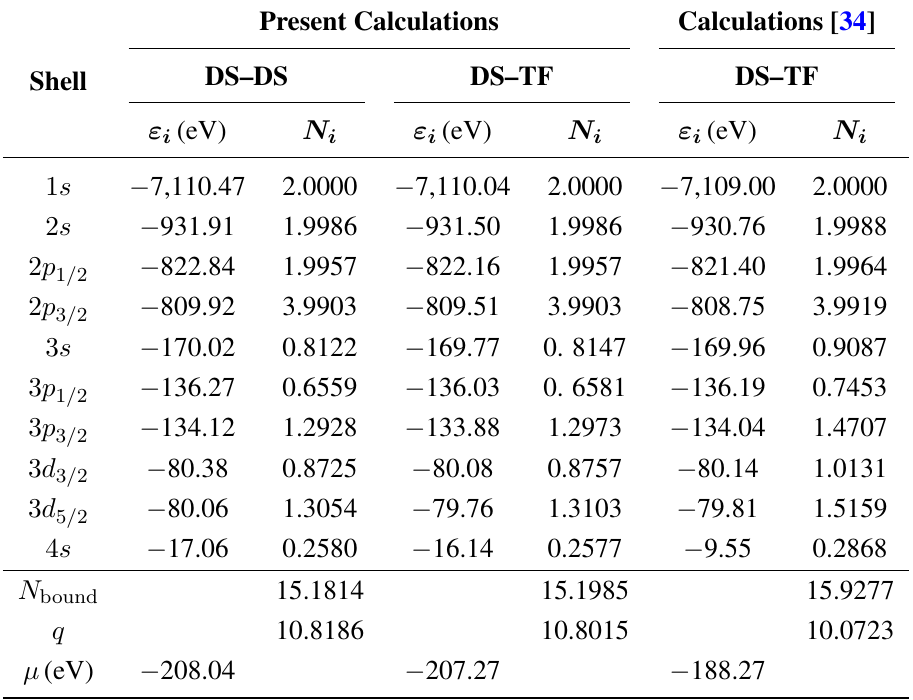
, level populations N i